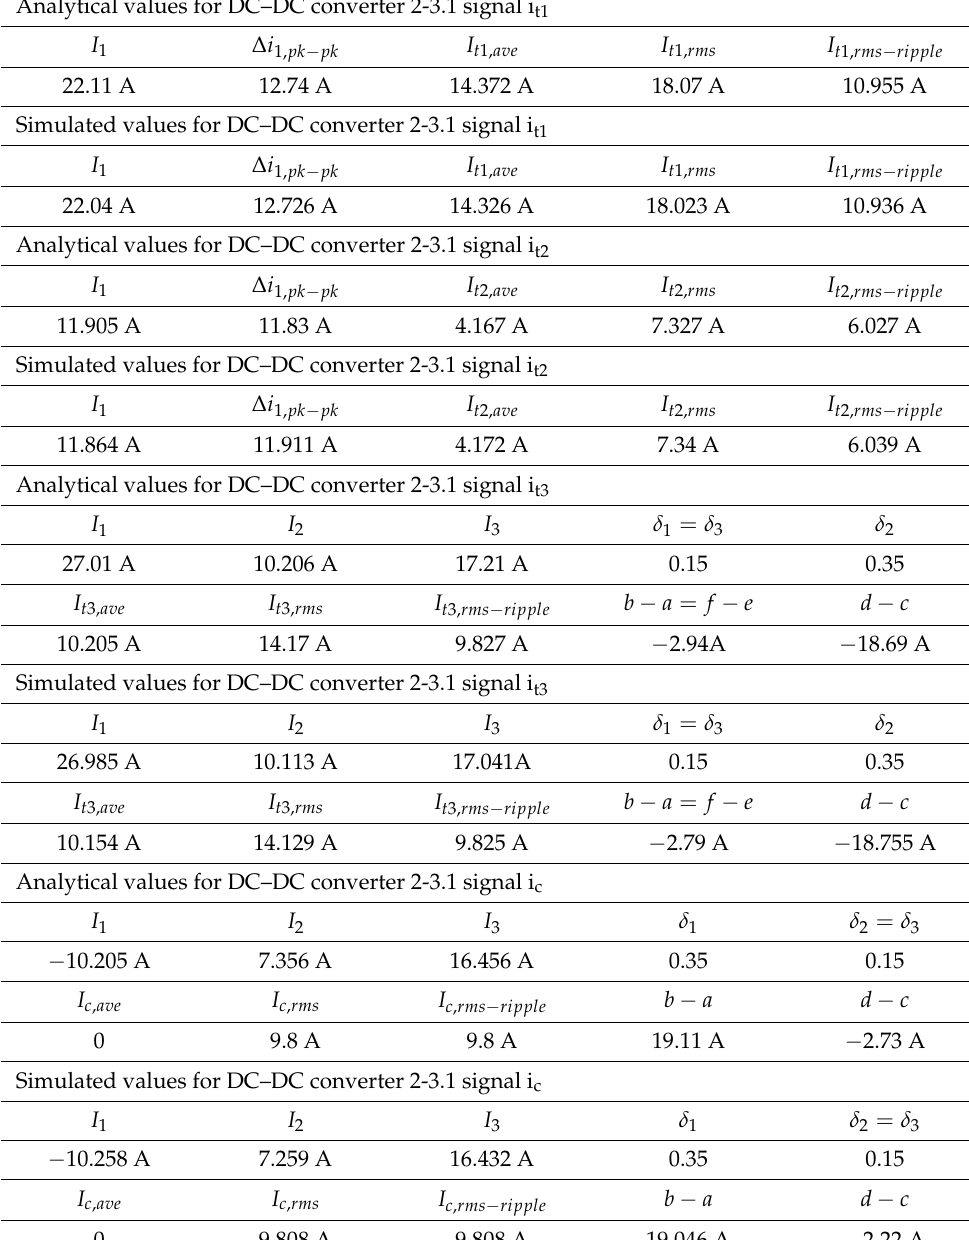
Table 3. Analytical and simulated date for converter 2-3.1 under